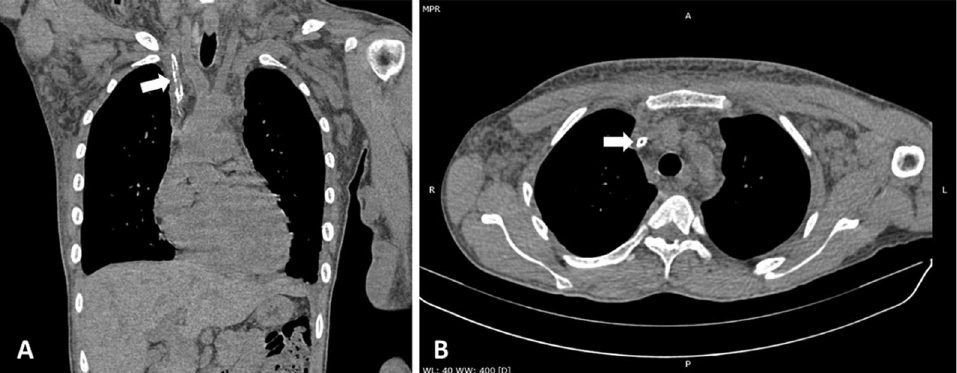
Fig. 1 Unenhanced coronal and axial CT scan of the thorax showing a hyperdense linear tubular structure (white arrows) measuring approximately 6.2 cm in length within the right brachiocephalic vein extending to the superior vena cava (SVC), which at first glance was concerning for a retained catheter fragment. However, the discontinuous and interrupted appearance of this hyperdense structure, with a visible lumen suggested a calcified fibrin sheath